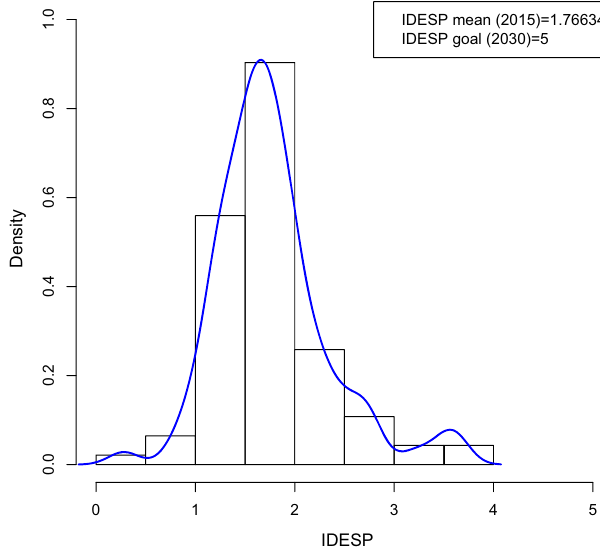
Figure 2. IDESP values distribution in Guarulhos, São Paulo State, Brazil in 2015.